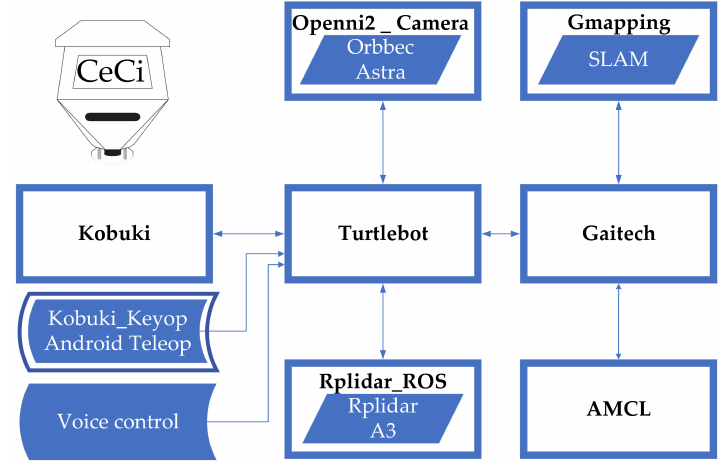
Figure 10. CeCi diagram.